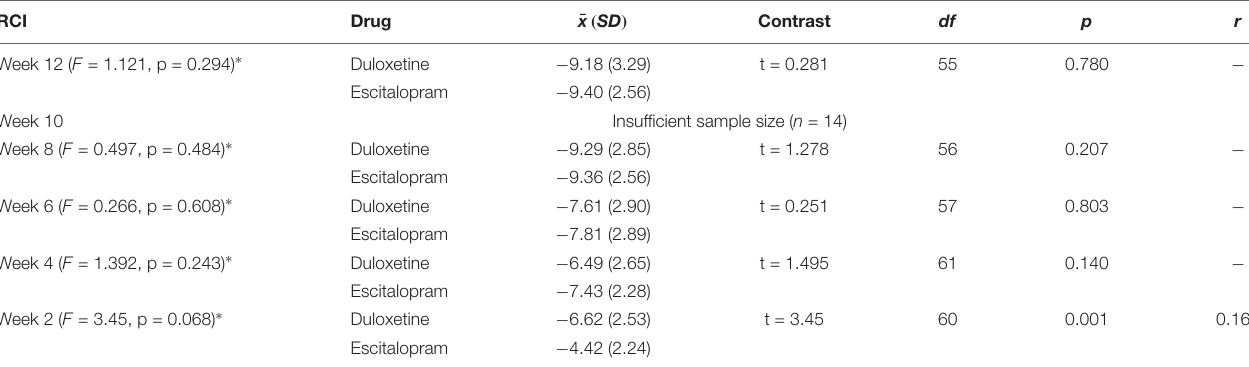
TABLE 9 | Mean, bivariate analysis, and homogeneity test between the variables type of treatment and RCI in all the weeks of treatment. RCI Drug ¯ x ( SD ) Contrast df p r Week 12 ( F = 1.121, p = 0.294)